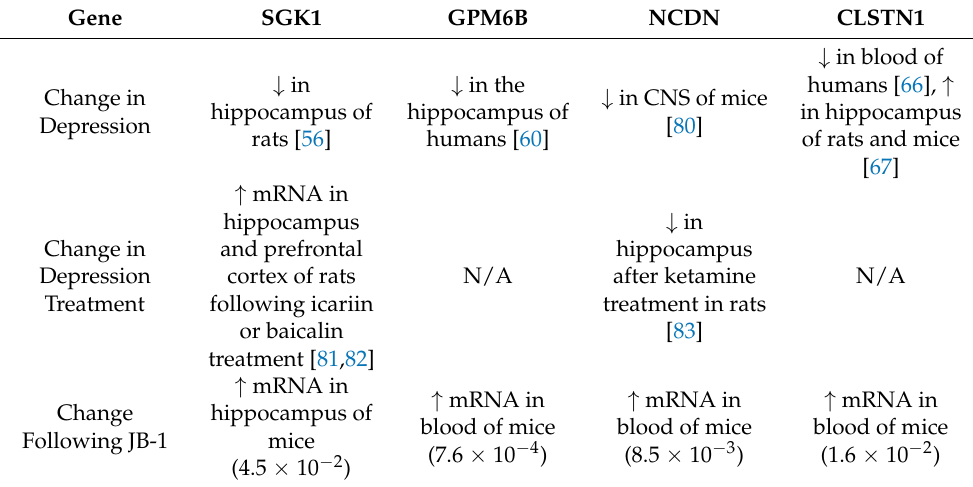
Table 3. Differential expression of genes relevant to depression, in depression, after established antidepressant treatment, and following JB-1 treatment in mice. The up and down arrows represent the direction of change in pathway expression in our findings and in